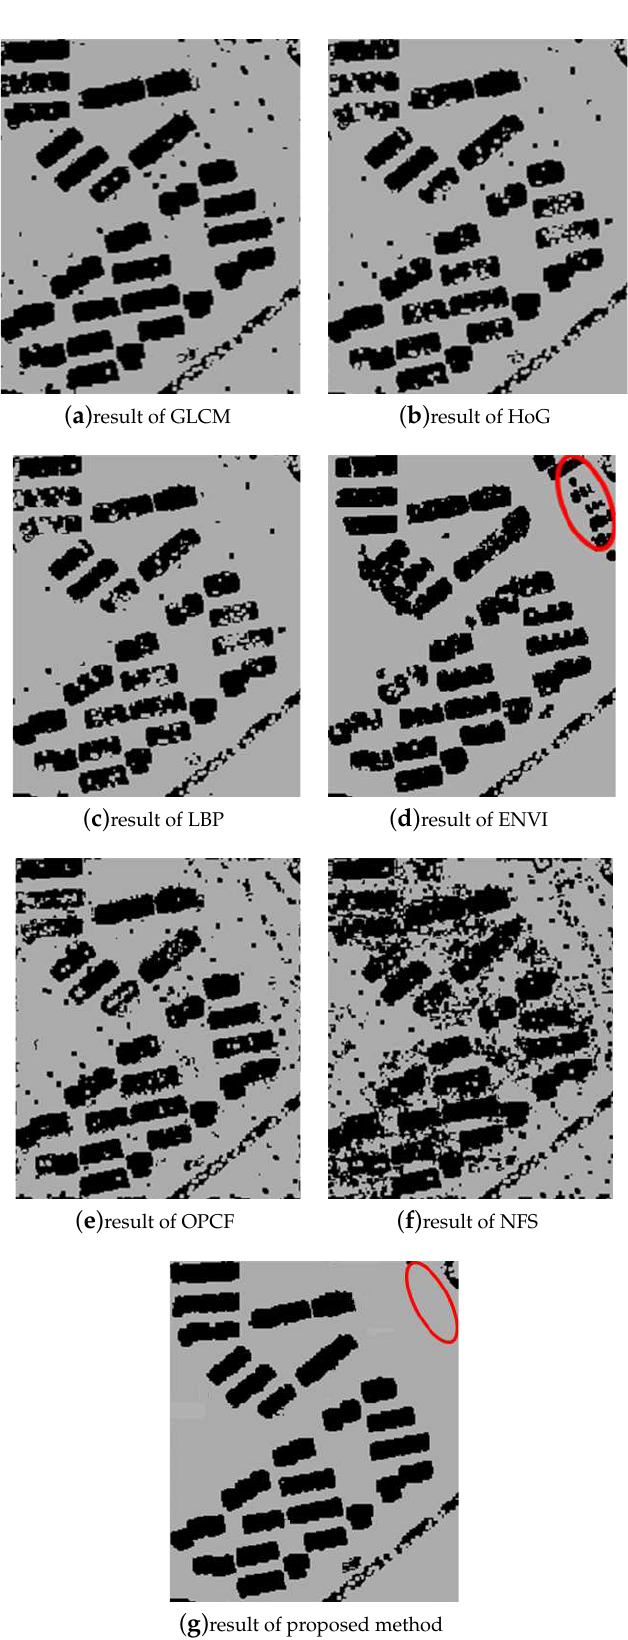
Figure 12. Building extraction results of HDR